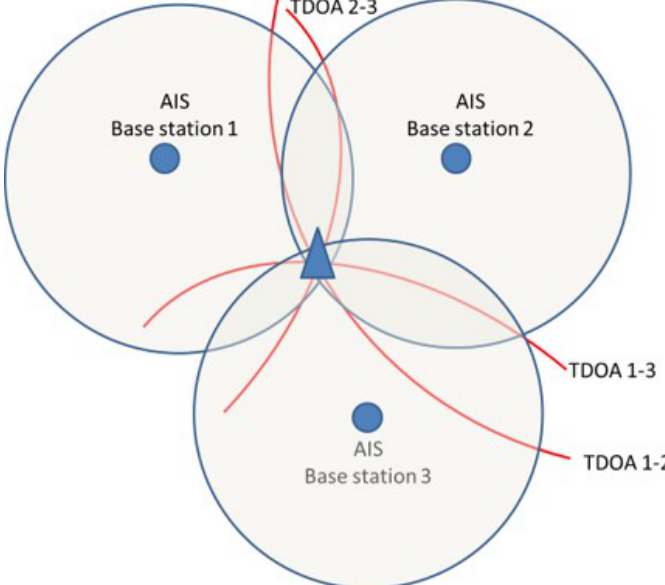
Figure 2. Basic triangulation with TDOA positioning. The three receiving nodes (blue circles) measure the TOA of the signal transmitted by the target (blue triangle). Exploiting the difference of TOAs, the position of the target is